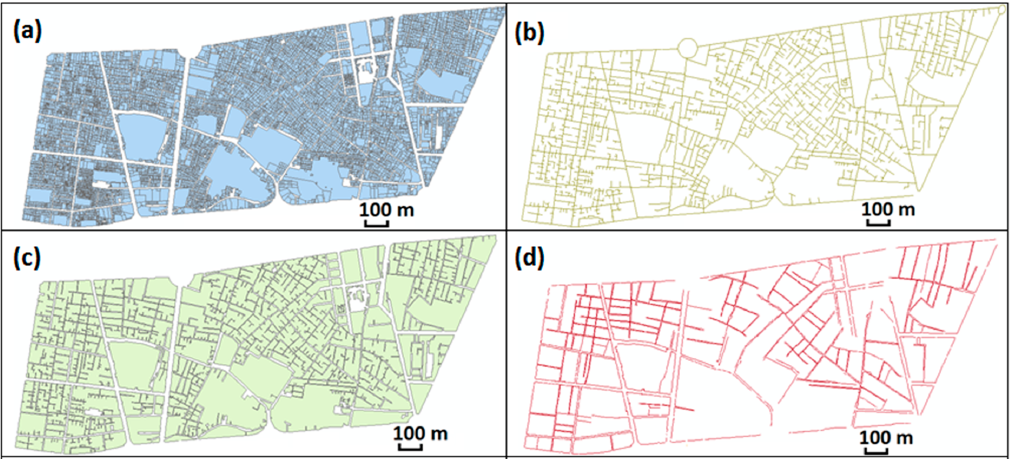
Figure 2. Urban layout of Tehran district 12: ( a ) parcels that have separate land use or ownership title; ( b ) paths; ( c ) blocks that are isolated by the paths surrounding them; and ( d ) edges.